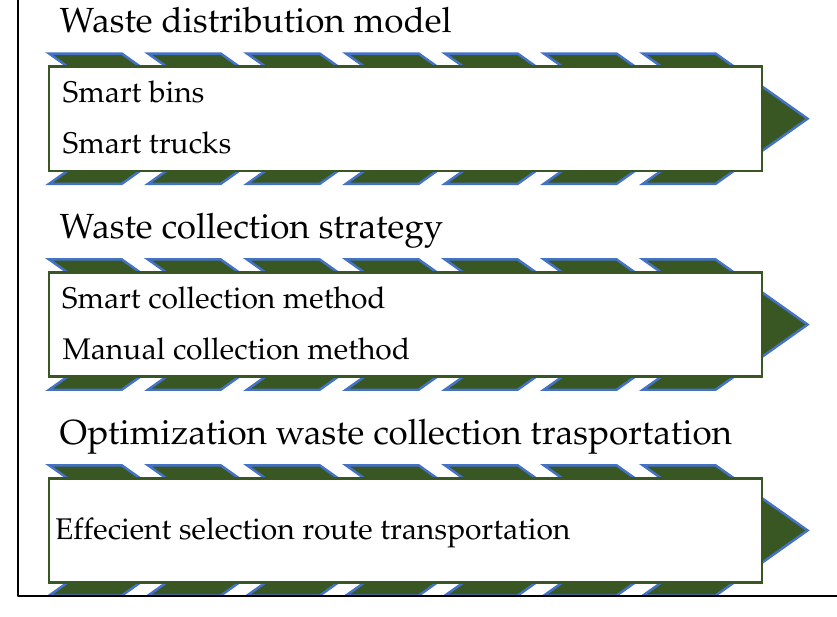
Figure 7. Waste management system phases.